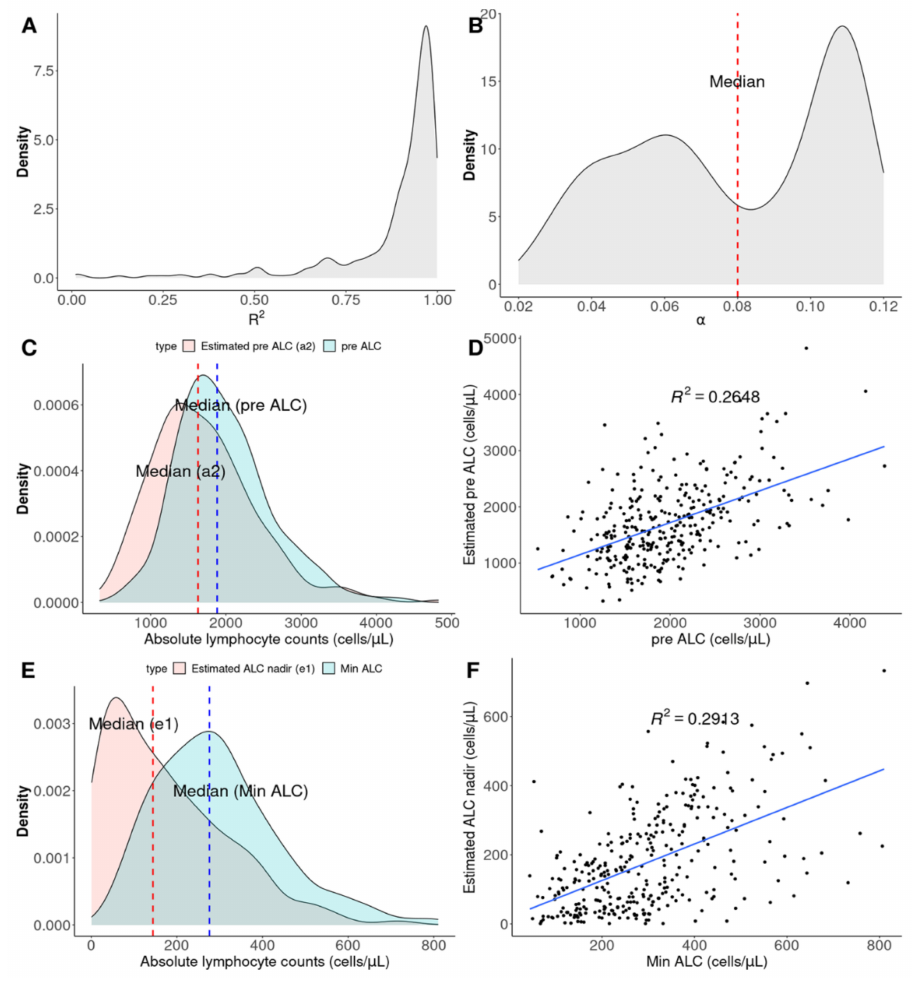
Figure 2. Characteristics of exponential functions ( ALC = a 1 e − α time + e 1) fitted by ALCs from each of the 323 patients. Density plots for ( A ) R 2 and ( B ) α (slope) of fitted functions. ( C ) Density plot and ( D ) scatterplot to compare pre-ALCs with estimated pre-ALCs ( a 2 = a 1 + e 1). ( E ) Density plot and ( F ) scatterplot to compare min-ALCs with estimated ALC nadirs ( e 1). ALC—absolute lymphocyte